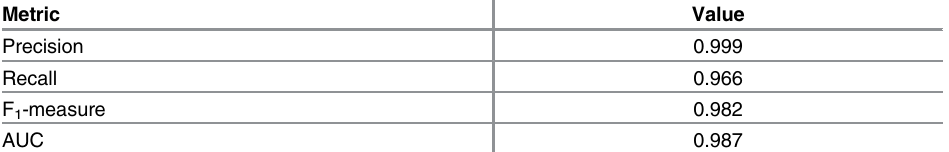
Table 8. Evaluation metrics of cross-validation experiment over UniProtKB/Swiss-Prot prokaryotic entries with pathway annotations of manual assertion